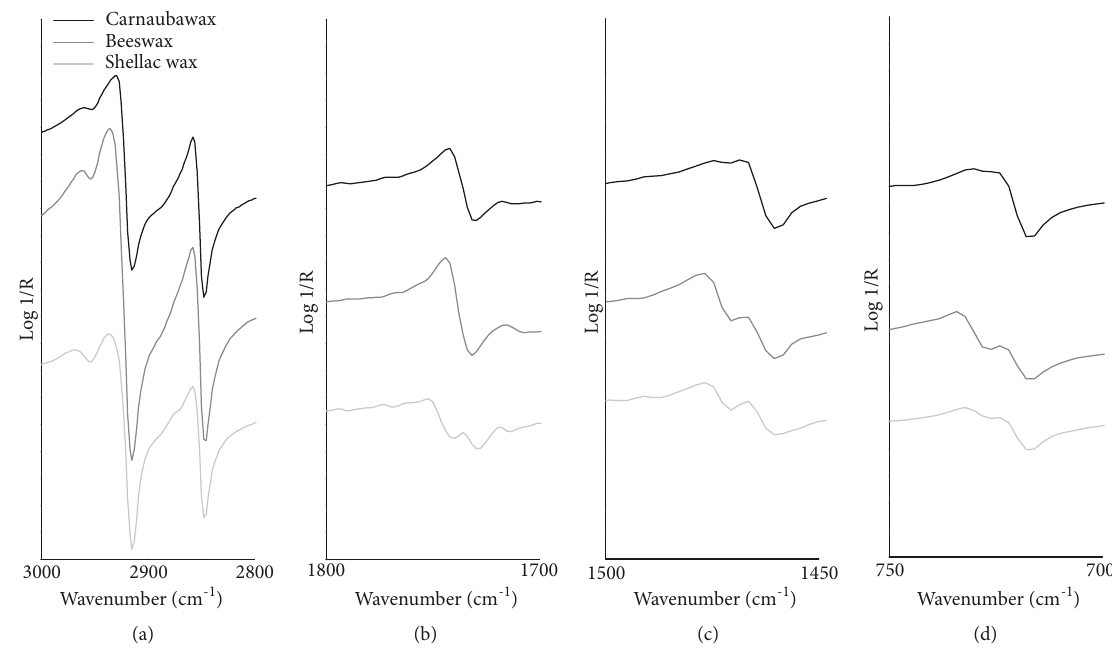
Figure 4: FTIR totalreflectionmodespectra(beforetheapplication of theKKT correction)of thestudied lipid materials(blackline:carnauba wax, gray line: beeswax, light gray line: shellac wax) in the regions of (a) CH stretching, (b) C=O stretching, (c) CH 2 scissoring, and (d) CH 2 rocking.